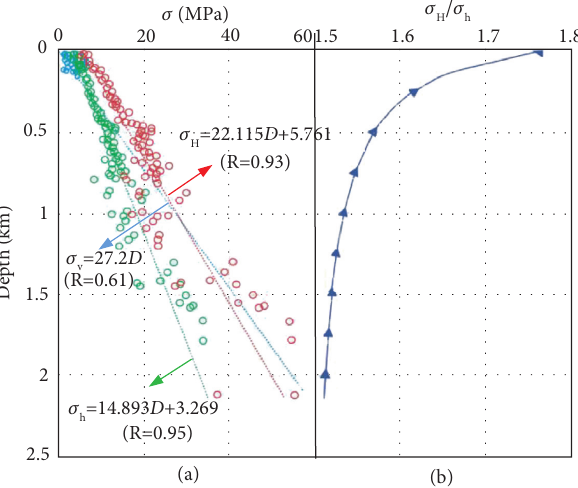
Figure 2: Measured stress variation with depth and regression equations (adapted from [47, 48]). (a) Measured stress variation with depth. (b) σ H / σ h variation with depth base on regression equations.